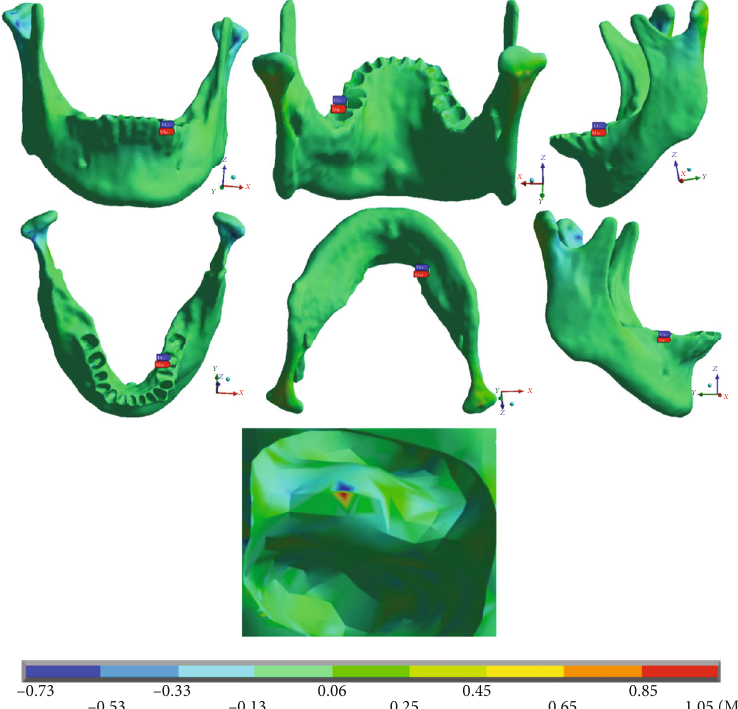
Figure 18: Normal stresses in Z , mandibular bone. The red marker indicates the maximum stresses, and the blue marker indicates the minor